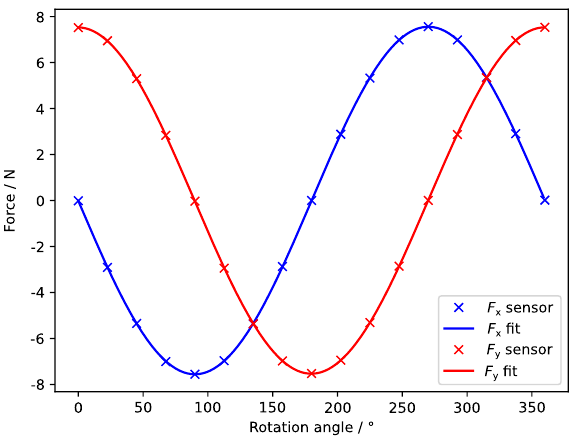
Figure 11. Force readings and sine fitting for F x and F y .